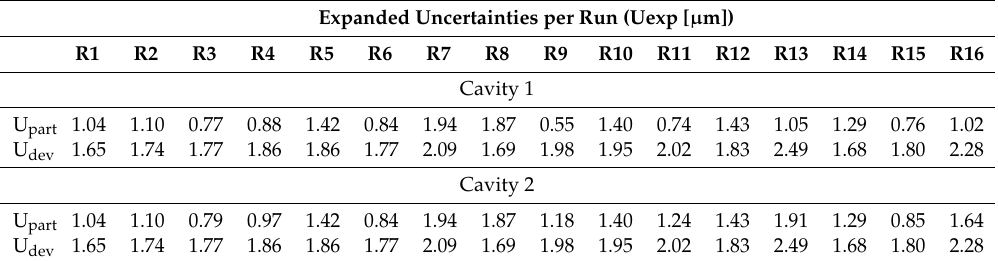
Table 5. Expanded uncertainty for pillar height and height deviations measurements per